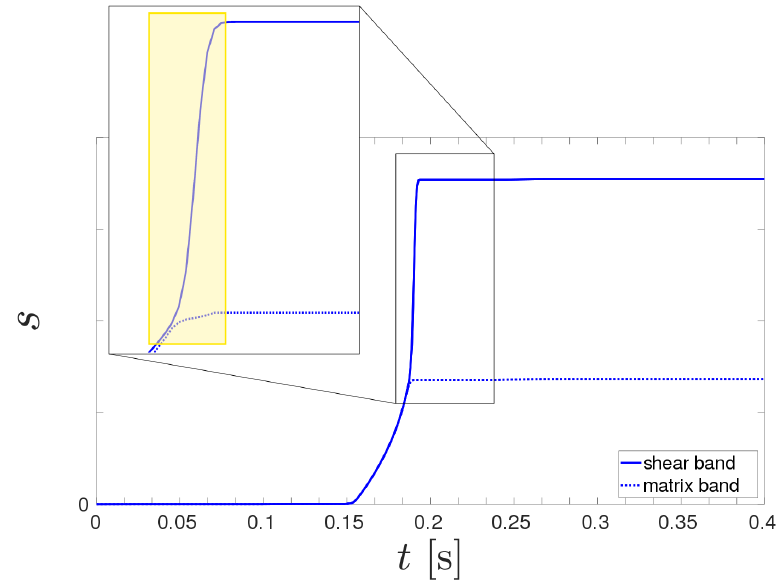
Figure 15. The evolution of the effective plastic strain s (cf. Equation (9)) for the representative elements corresponding to shear and matrix bands, respectively (see highlighted elements in Figure 14).